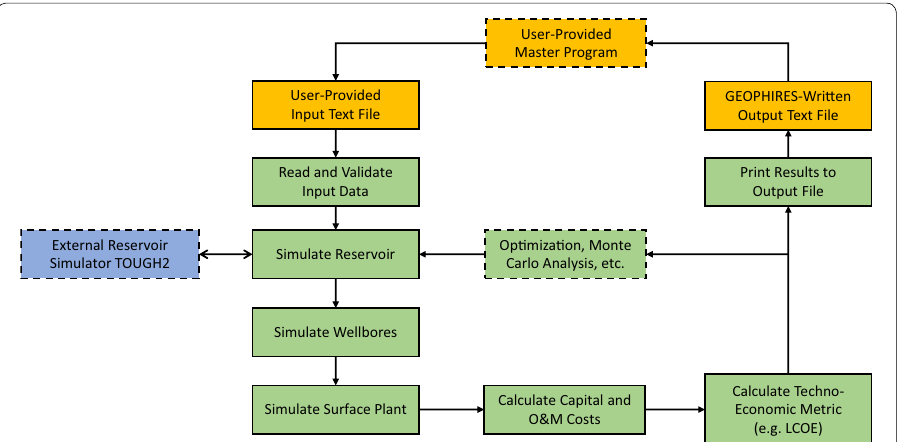
Fig. 1 GEOPHIRES software architecture. Green, orange, and blue rectangles refer, respectively, to internal GEOPHIRES components, external user interface components, and the external reservoir simulator